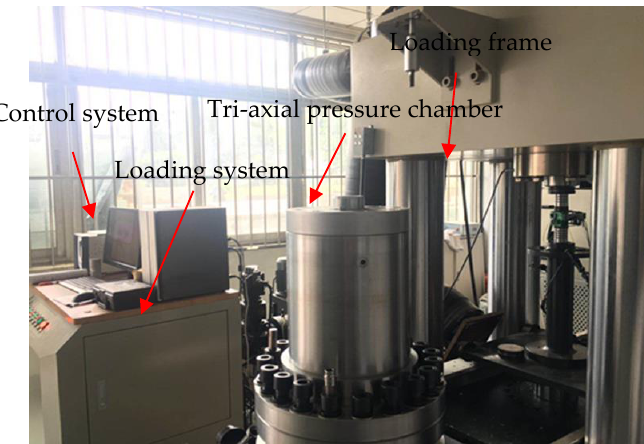
Figure 4. Multifunctional triaxial testing machine.